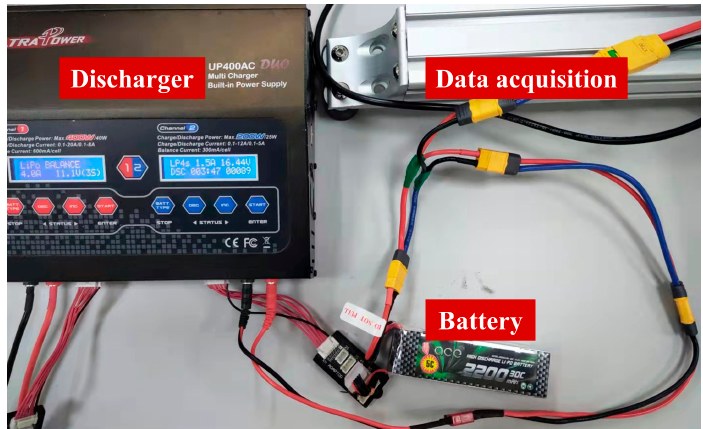
Figure 17. Measurement set-up for battery data acquisition.